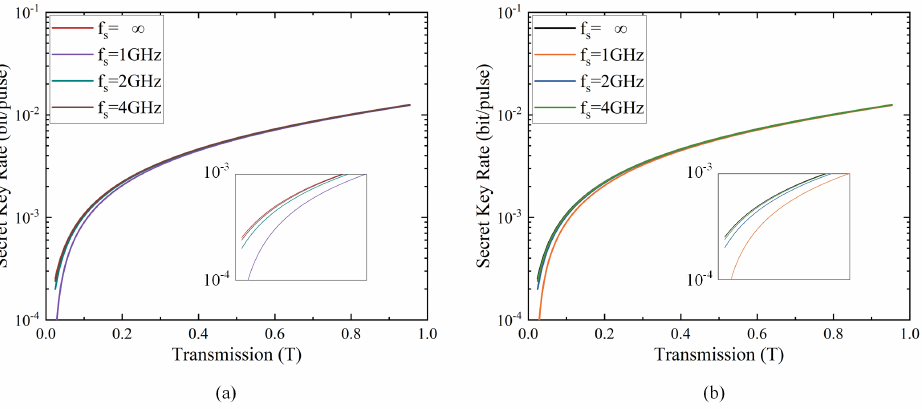
Figure 4. lThe secret key rate of the DM CVQKD system as a function of the transmission with f s ∈ { 1,2,4, ∞ } GHz by applying homodyne detection of ( a ) a four-state scheme and ( b ) an eight- state scheme. The lines from the top down denote the secret key rates of the system with frequencies ∞ GHz, 4 GHz, 2 GHz and 1 GHz, respectively. The higher sampling frequency means a higher secret key rate.